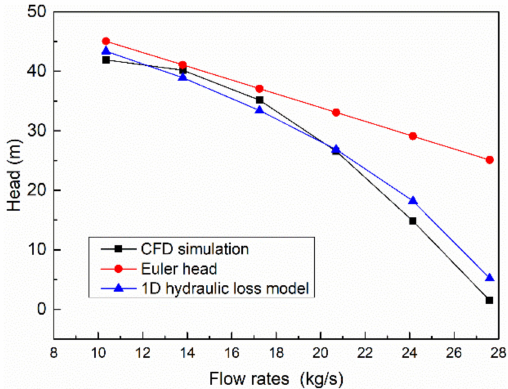
Figure 4. Comparison between numerical and theoretical results of the pump.